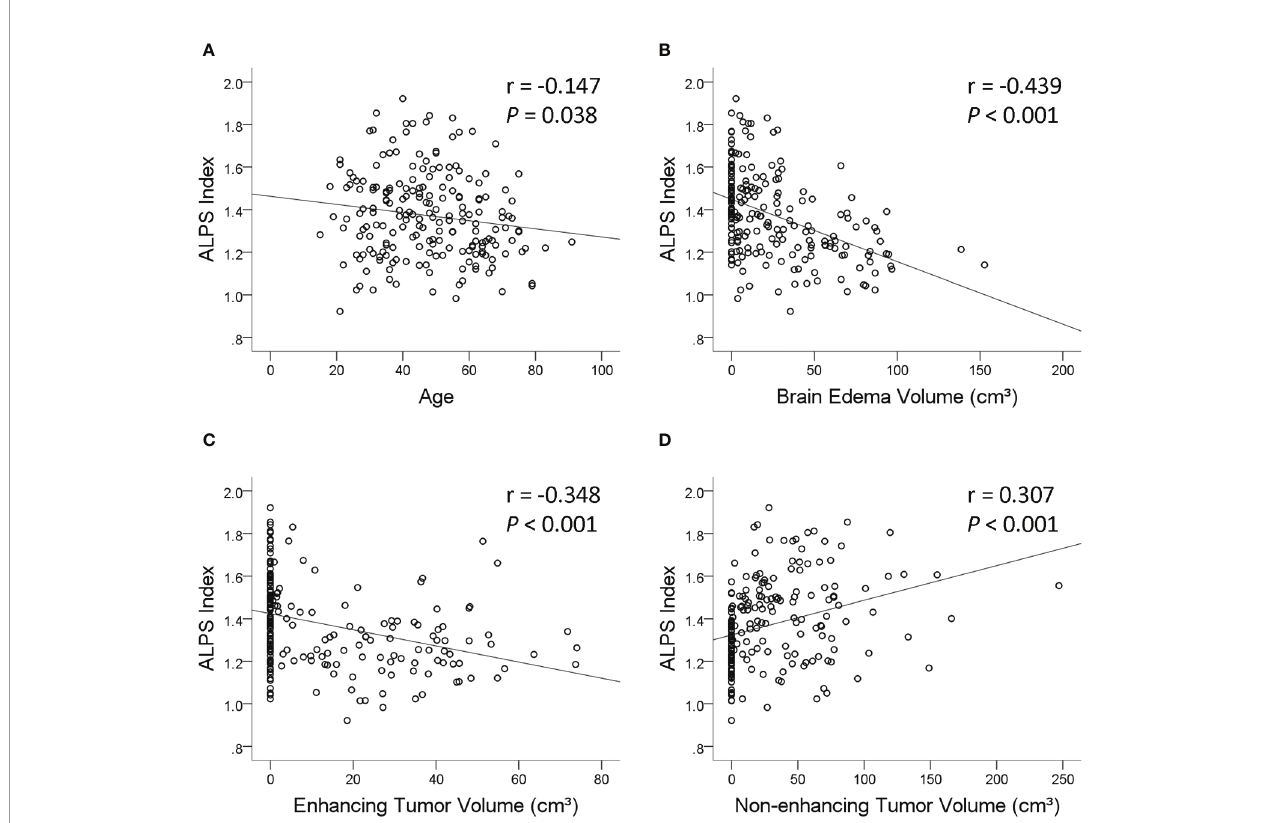
FIGURE 3 | Scatterplots with regression line showing the correlations of the analysis along the perivascular space (ALPS) index with age (A) , peritumoral brain edema volume (B) , enhancing tumor volume (C) , and non-enhancing tumor volume (D)